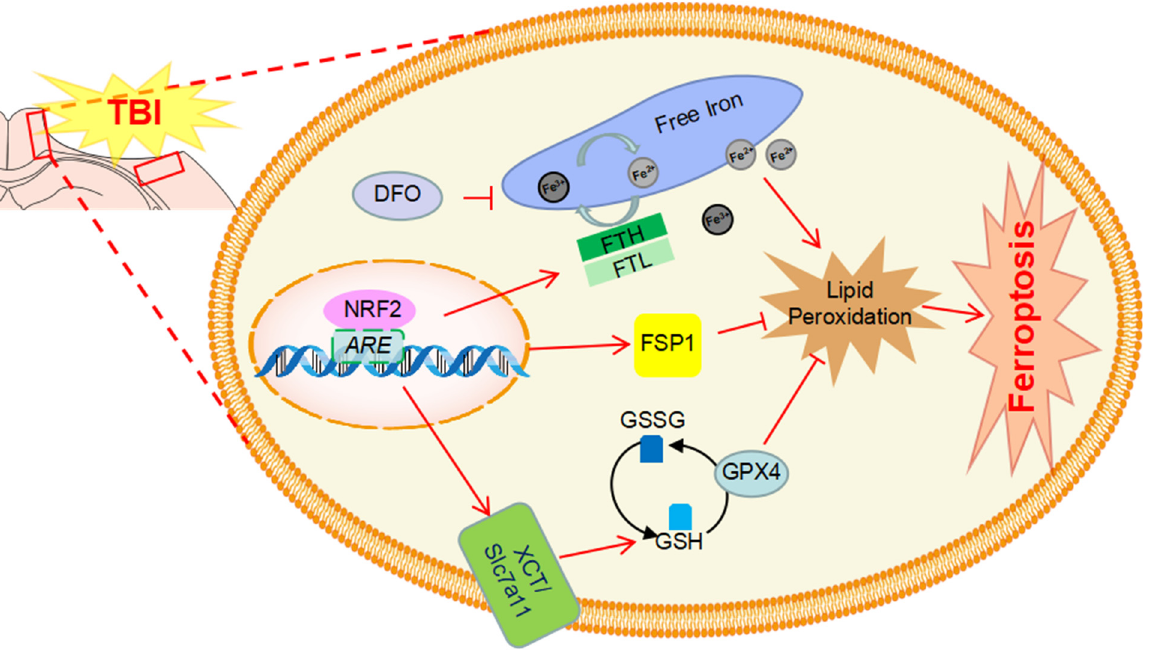
Figure 6. Schematic regulation diagram of NRF2 on ferroptosis after TBI. NRF2 regulates ferroptosis